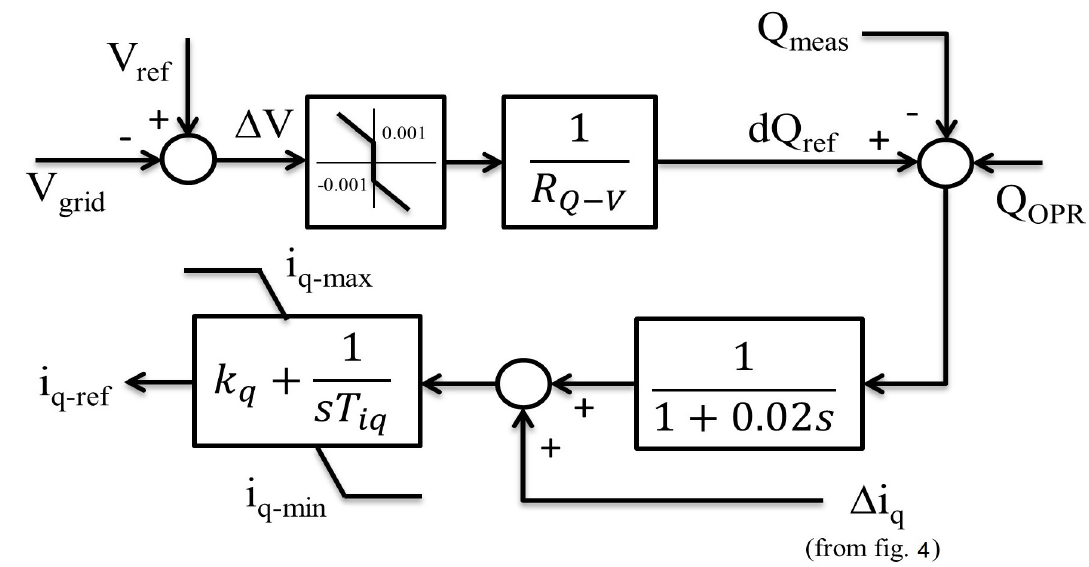
Figure 3. Block diagram of the BESS voltage